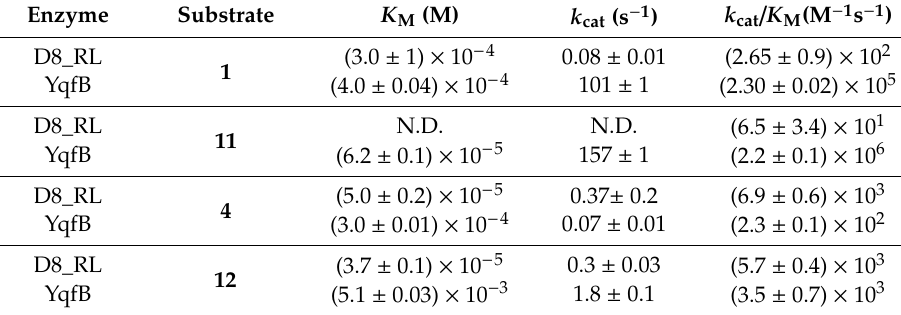
Table 2. Catalytic parameters of D8_RL and YqfB. Both recombinant enzymes contain C-terminal 6-His tags. Activity was measured in 50 mM potassium phosphate bu ff er, pH 8.0, at 22 ◦ C. Rate